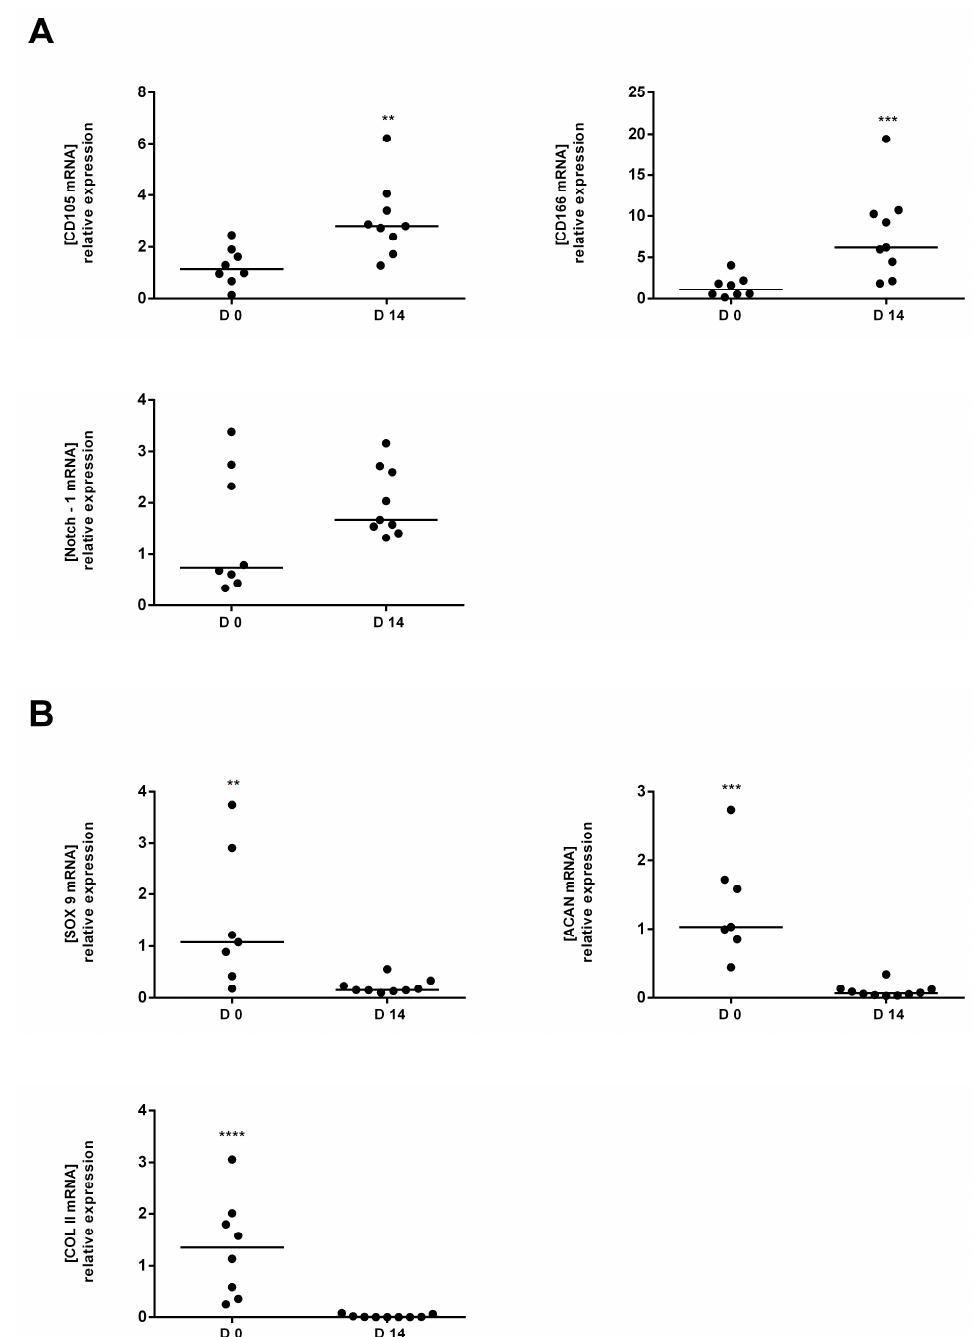
Figure 3. Comparative analysis of MSC and Chondrocyte markers between tissue (D0) and proliferated cells (D14) in Mild OA. ( A ) The mRNA expression levels of CD105, CD166 and Notch 1 (MSC markers) at D14 versus D0; ( B ) The mRNA expression levels of Sox9, Acan and Col II (chondrocytes markers) at D14 versus D0. D0 is used as the control expression to normalise results. ** p < 0.01, *** p < 0.001, **** p < 0.0001, Student’s t -test ( n = 8 in Mild OA, n = 6 in severe